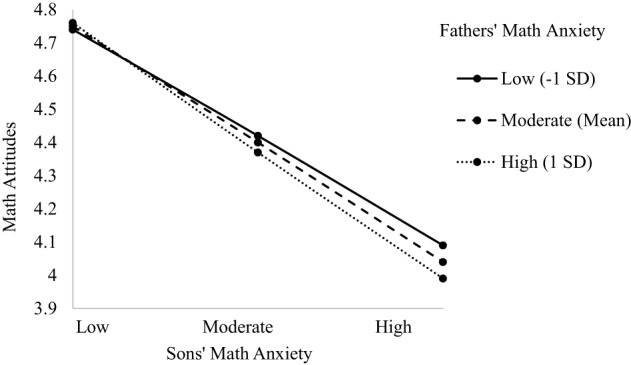
Three-way interaction predicting math attitudes from Fathers' and Sons' math anxiety.